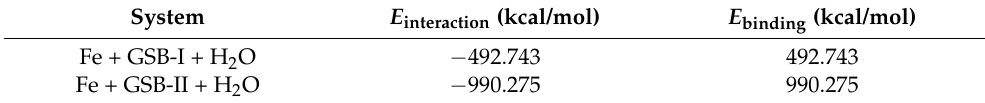
Figure 10. Side and top view for equilibrium adsorption configuration of GSB inhibitors at the Fe substrate. Table 6. Interaction energy and binding energy values between the inhibitors and Fe(110)